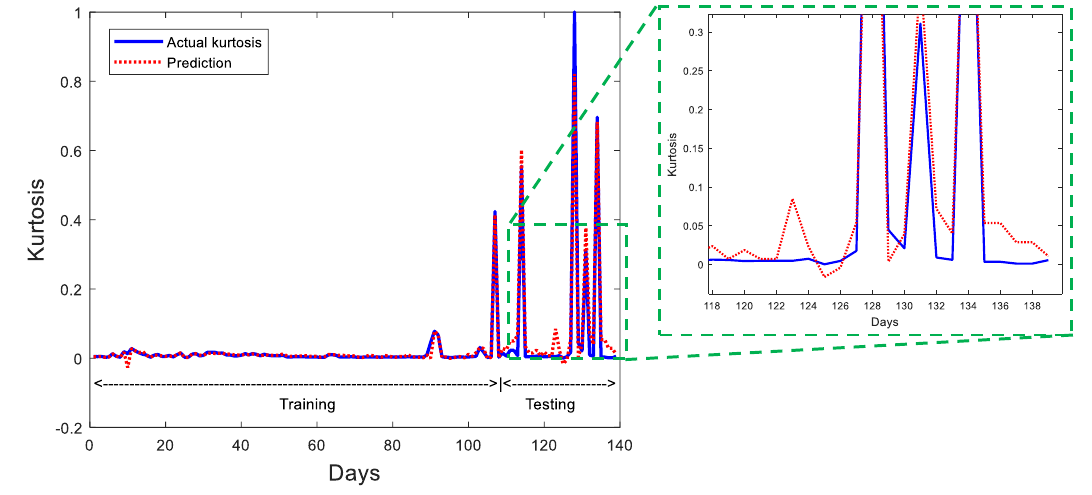
Figure 7. PANFIS prediction of kurtosis feature.